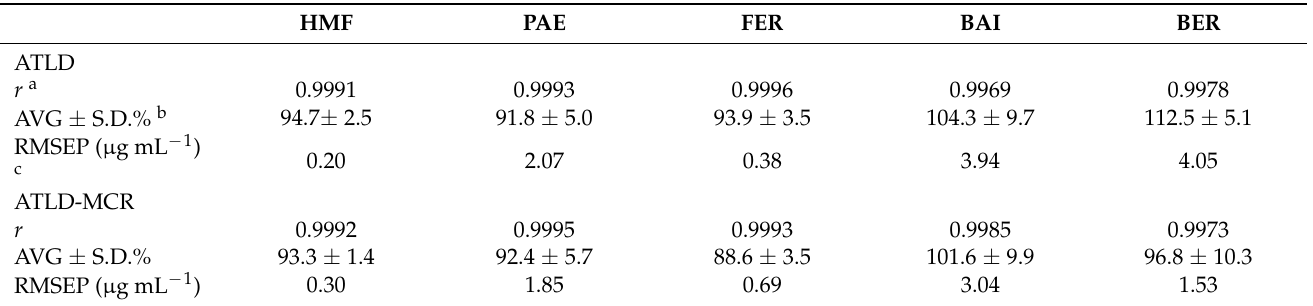
Table 1. Accuracy of five target analytes in spiked prediction samples (P01–06) of WQY commercial products using ATLD and ATLD-MCR methods. PAE FER BAI BER